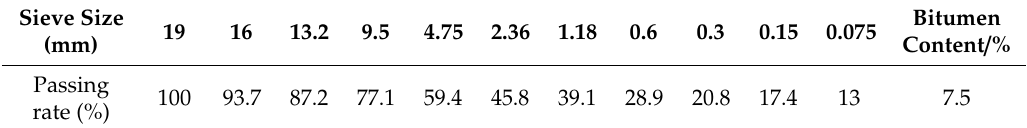
Table 1. Mix ratio of asphalt concrete in the test.